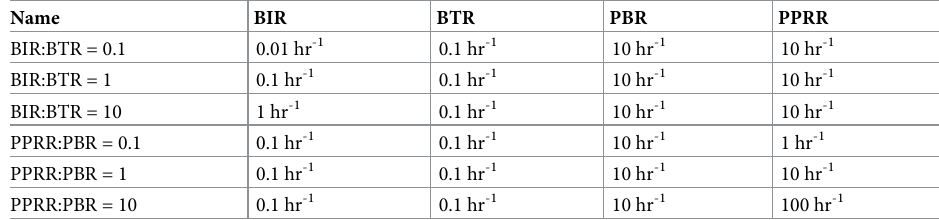
Table 4. Ratio Parameter